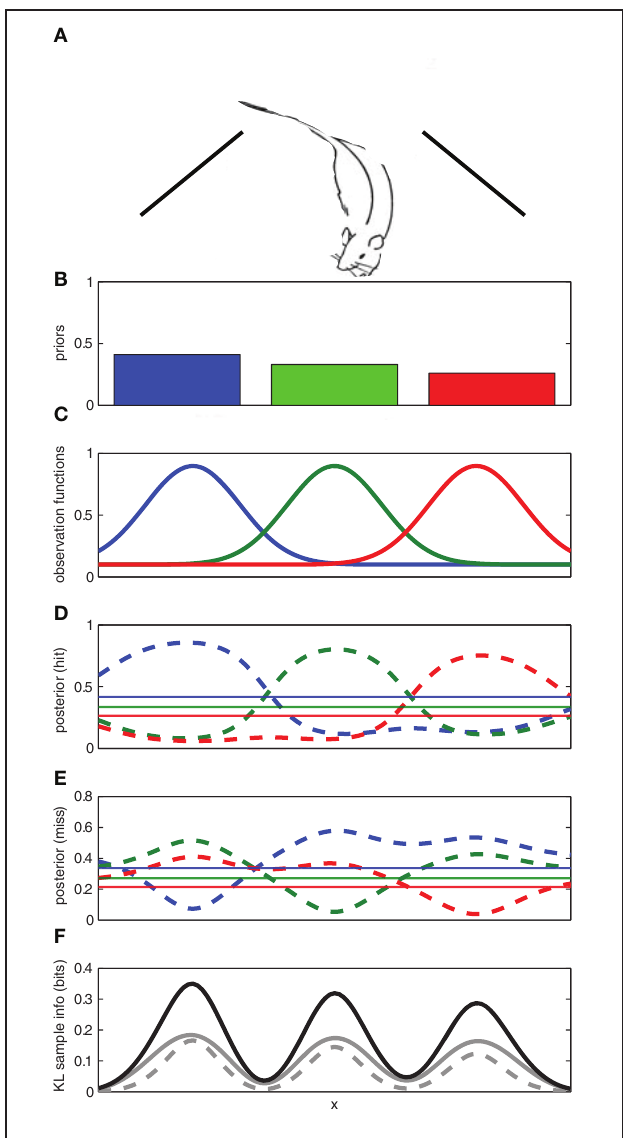
FIGURE 2 | Using expected sampling information to find an object in a one-dimensional space. (A) The rat searches along a one-dimensional space (e.g., a wall) for an object. (B) The prior probabilities for the left, middle, and right locations. (C) The known observation functions for each of the three competing hypotheses for the location of the object. (D) The posterior distribution for each hypothesis given an observation of the object ( hit ) at a given location. (E) The posterior distribution for each hypothesis given a failure to observe the object ( miss ) at a given location. (F) The expected sample information for a hit ( solid gray ), a miss ( broken gray ), and the sum ( black ). The regions with the highest expected sample information across x are expected to yield the most informative samples. Here the prior probabilities for each hypothesis were p ( h 1 ) = 0 . 3, p ( h 2 ) = 0 . 2, and p ( h 3 ) = 0 .